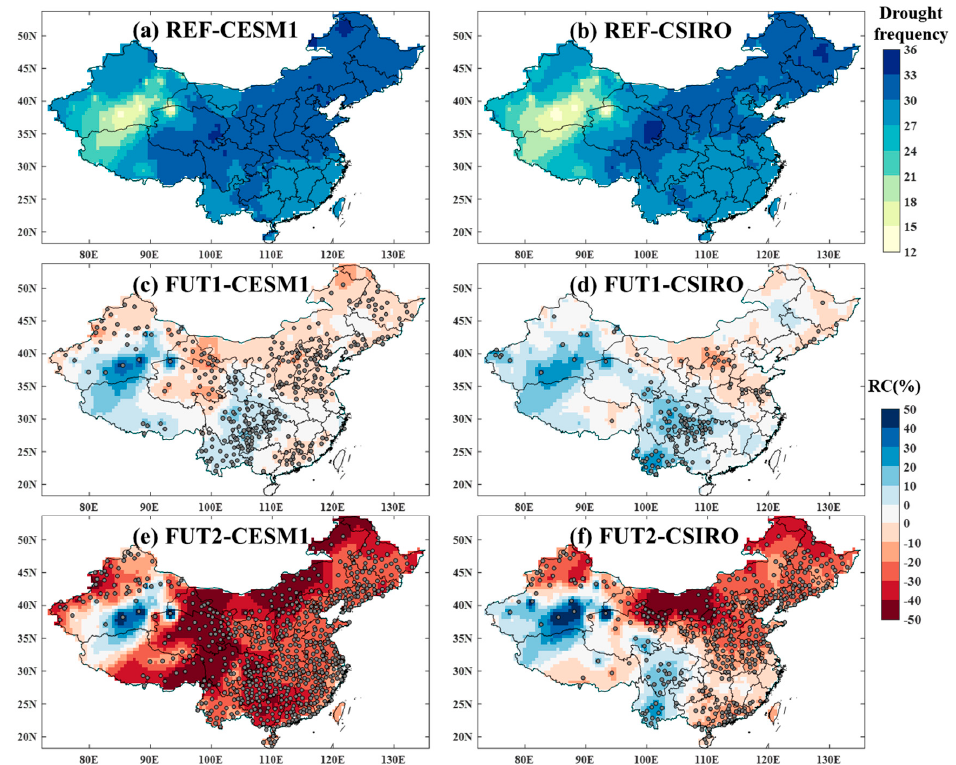
Figure 6. Spatial pattern of drought frequency in the reference period (REF) and its relative changes (RC) for future periods (FUT1, FUT2) for two climate model ensembles. Stations that present statistically significant changes are marked with filled dots. ( a ) Drought frequency in REF for CESM1; ( b ) Drought frequency in REF for CSIRO; ( c ) The RC of drought frequency in FUT1 for CESM1; ( d ) The RC of drought frequency in FUT1 for CSIRO; ( e ) The RC of drought frequency in FUT2 for CESM1; ( f ) The RC of drought frequency in FUT2 for